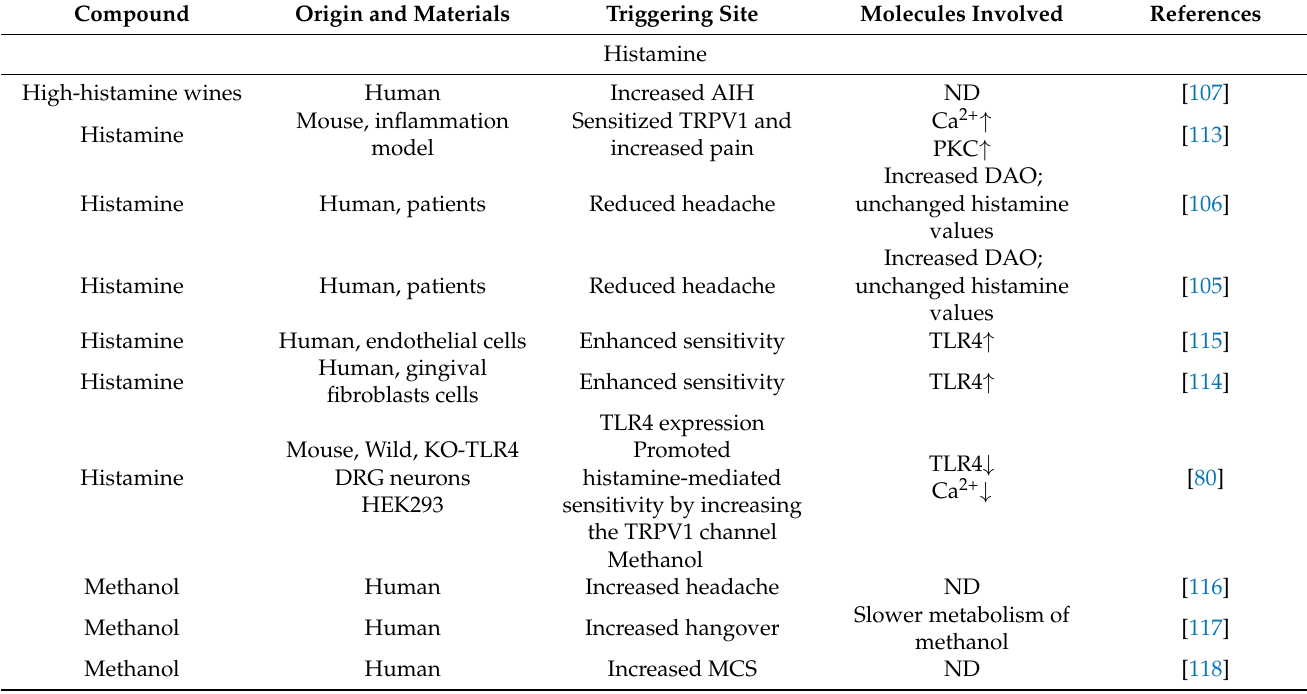
Table 4. Research on the effects of histamine and